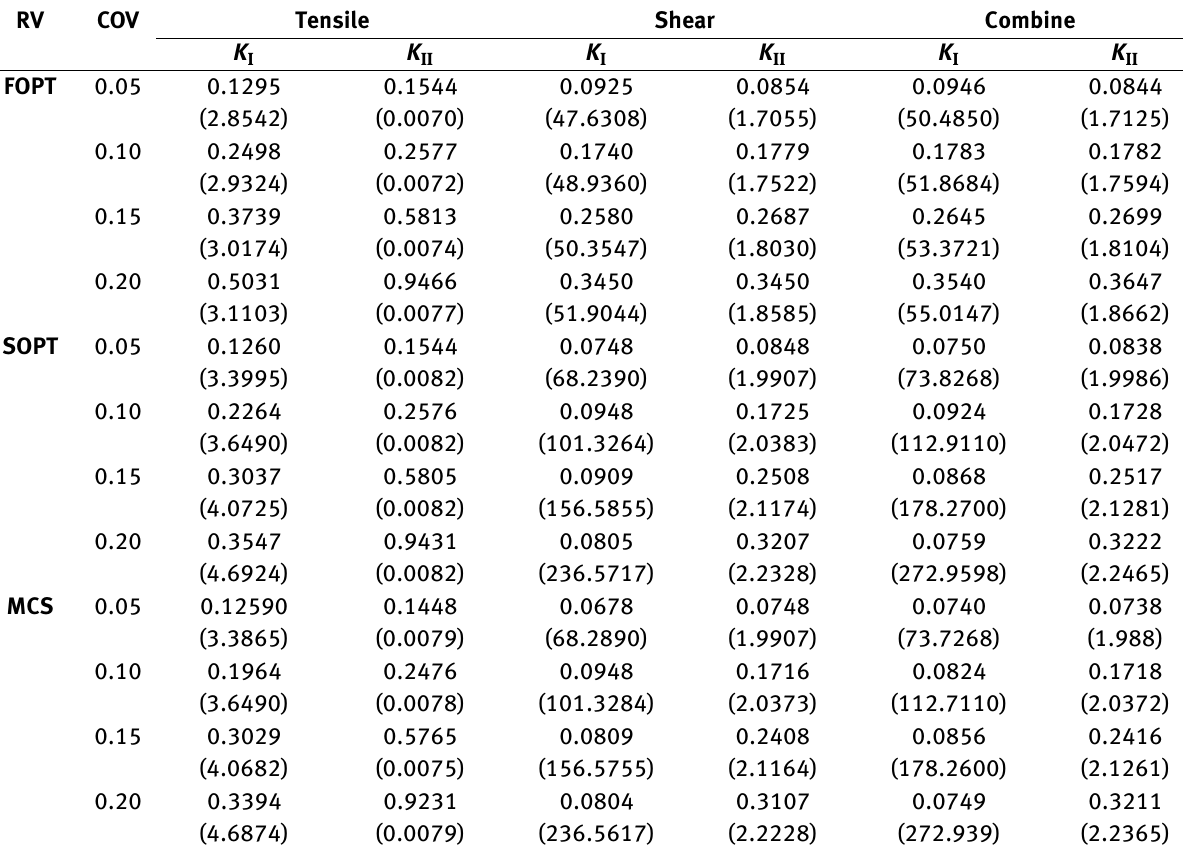
Table 2: Comparative study of normalized mean and COV of MMSIF using FOPT, SOPT and MCS RV COV Tensile Shear Combine K I